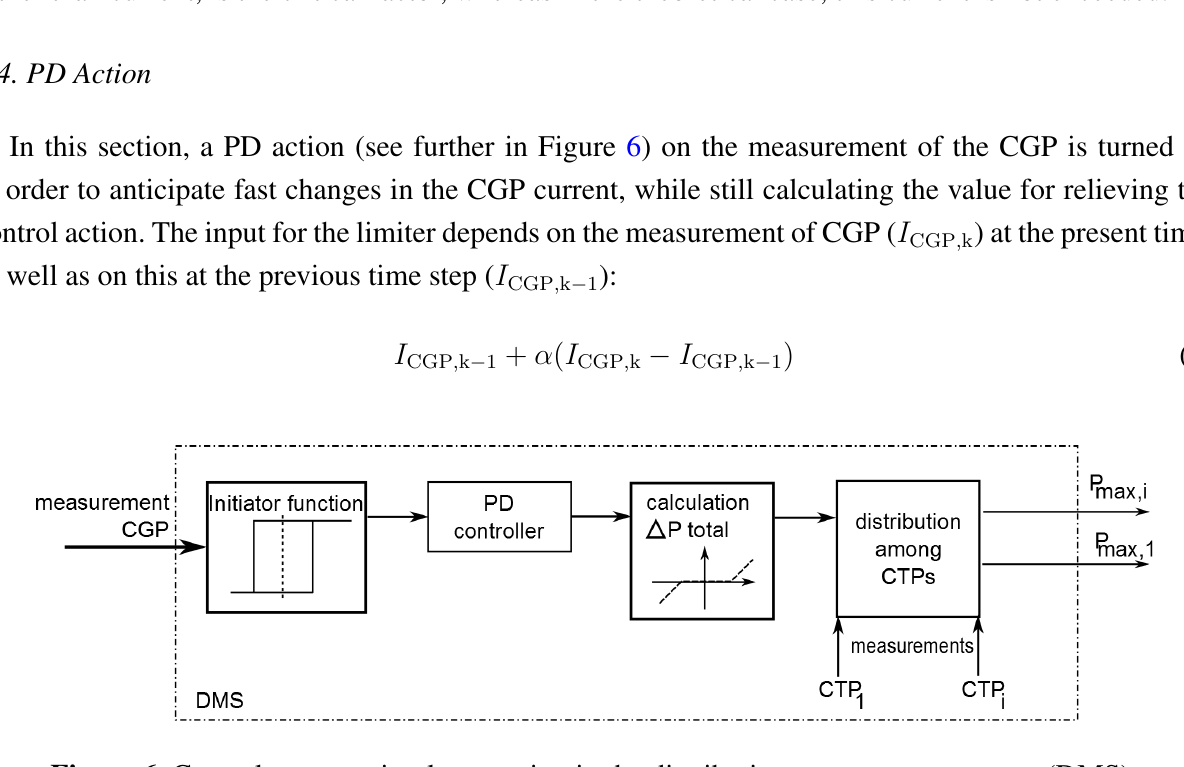
Figure 6. Control strategy: implementation in the distribution management system (DMS).